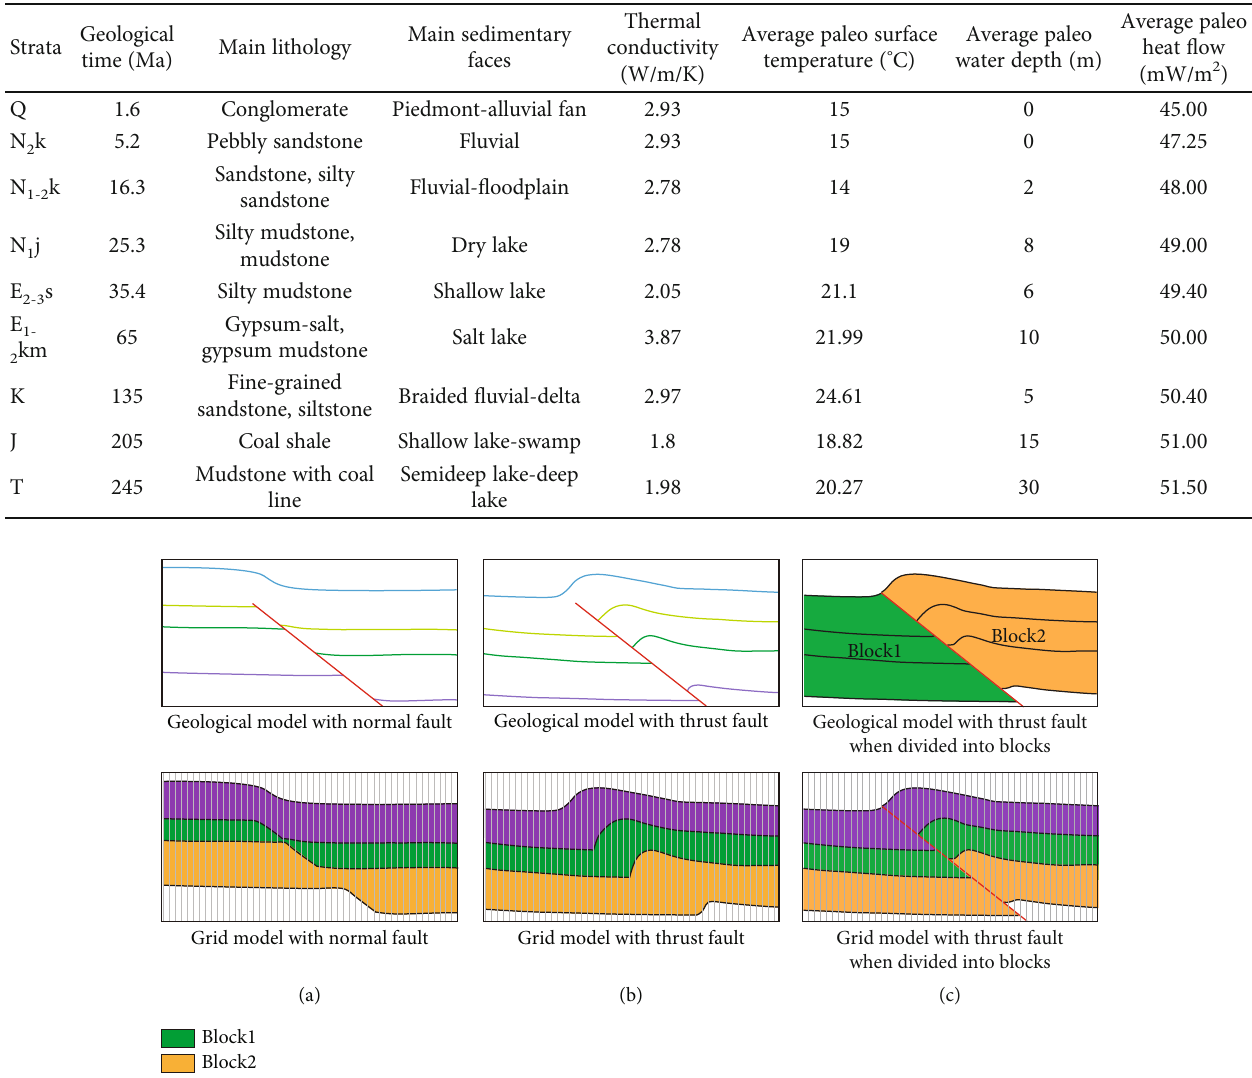
Table 1: Lithology, thermal conductivity, and boundary condition used in the basin modeling.